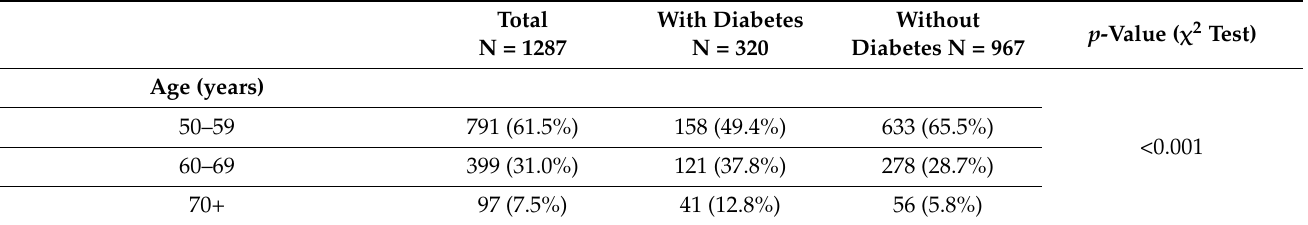
Table 1. Participant